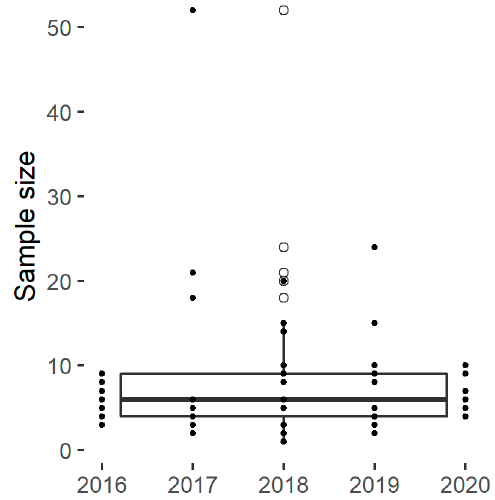
Figure 2. The sample size for selected papers.